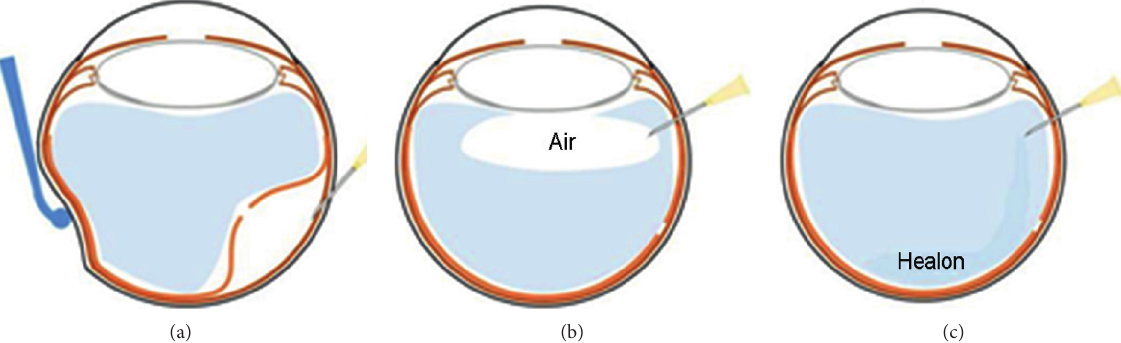
Figure 1: Schematic diagram of extrascleral drainage (a), air injection into the vitreous cavity (b), and viscoelastic agent injection into the vitreous cavity (c).